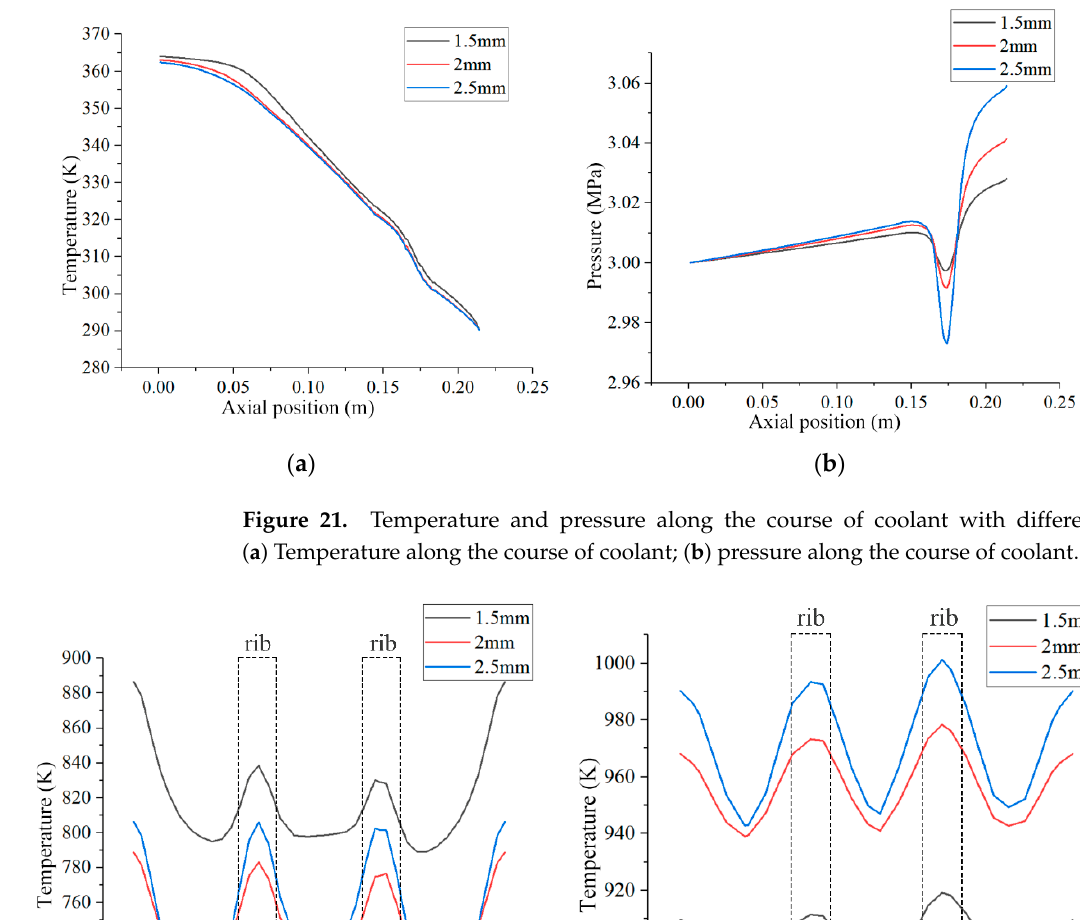
Figure 21. Temperature and pressure along the course of coolant with different rib widths. ( a ) Tem- perature along the course of coolant; ( b ) pressure along the course of coolant.